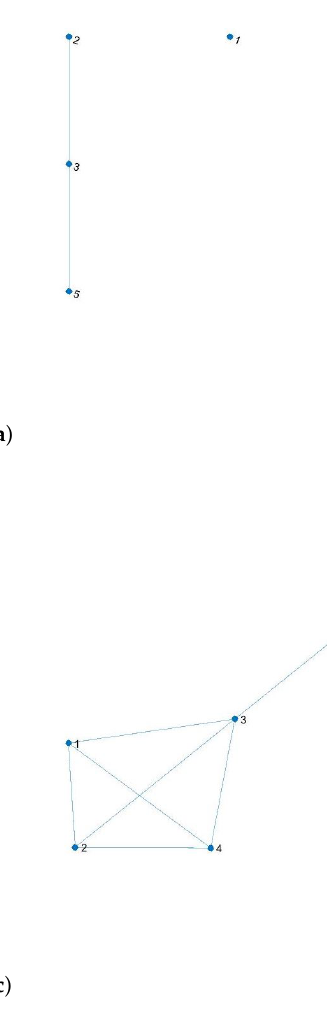
Figure 5. The simulated graphs G S ( δ ) with δ = 0.71. ( a ) The graph G S ( δ ) resulting from the BEKK model; ( b ) the graph G S ( δ ) resulting from the modified BEKK model; ( c ) the graph G S ( δ ) resulting from the DCC model; ( d ) the graph G S ( δ ) resulting from the modified DCC model. Vertex number refers to the associated asset. Table 3. Values of the Frobenius and the Kullback–Leibler loss functions: case N = 5 and δ = 0.71. BEKK Modified BEKK DCC Modified DCC F